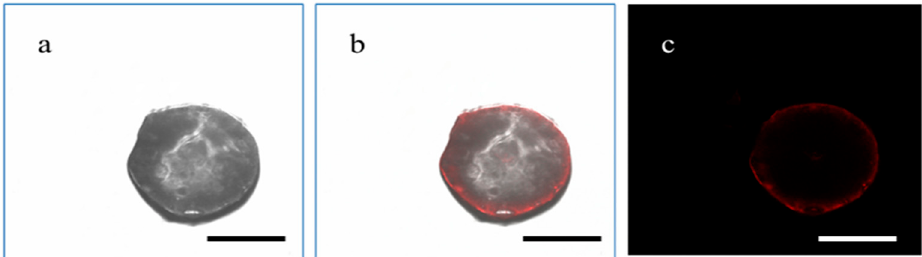
Figure 3. Confocal laser scanning microscopy (CLSM) images of alginate NPs-encapsulated microcapsule. ( a ) Brightfield, ( b ) Overlaid representation of all the components, and ( c ) Emission of the Rhodamine B(red) encapsulated in alginate NPs. Scale bar = 50 µm.